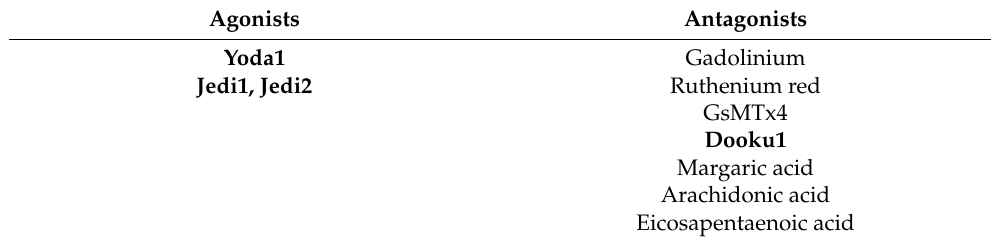
Table 1. Pharmacological modulators of Piezo1 channel. Bold letters indicate Piezo1-specific